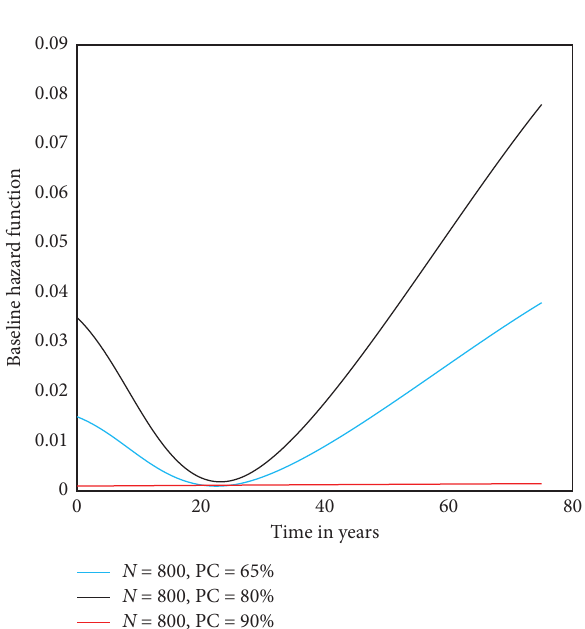
Figure 3: Baseline hazard function